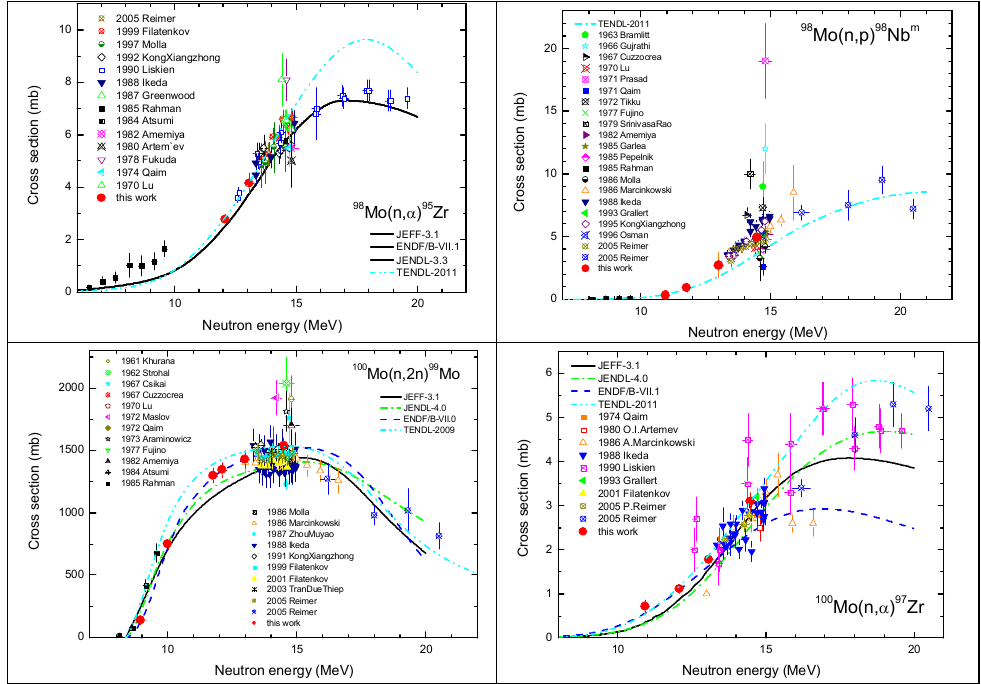
Figure 2. Experimental results for the indicated reactions compared with results from other authors and Evaluated Nuclear Data